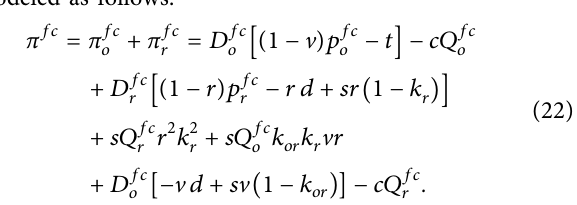
Figure 2: Fixed cross-channel return